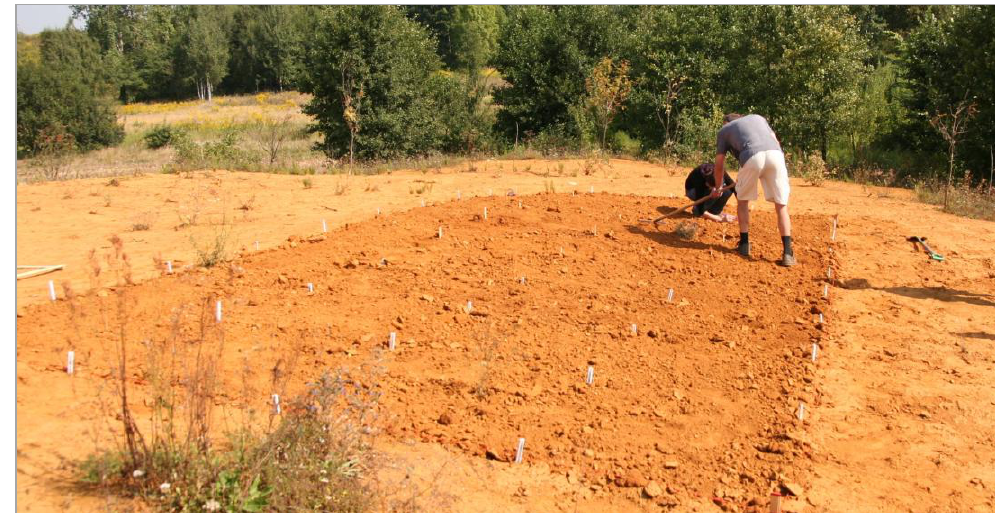
Fig. 6. View of the test plots on the "Dołki" spoil heap – ZGH Orzeł Biały in 2009 ( A. Rostański )